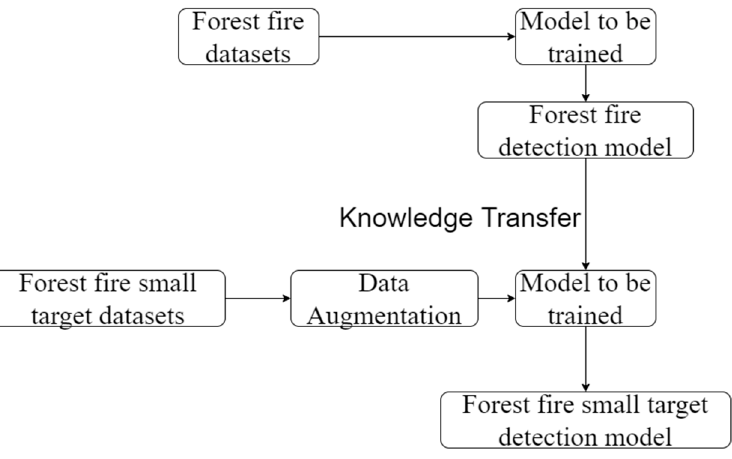
Figure 10. Transfer learning process of training the small-target forest fire detection model.